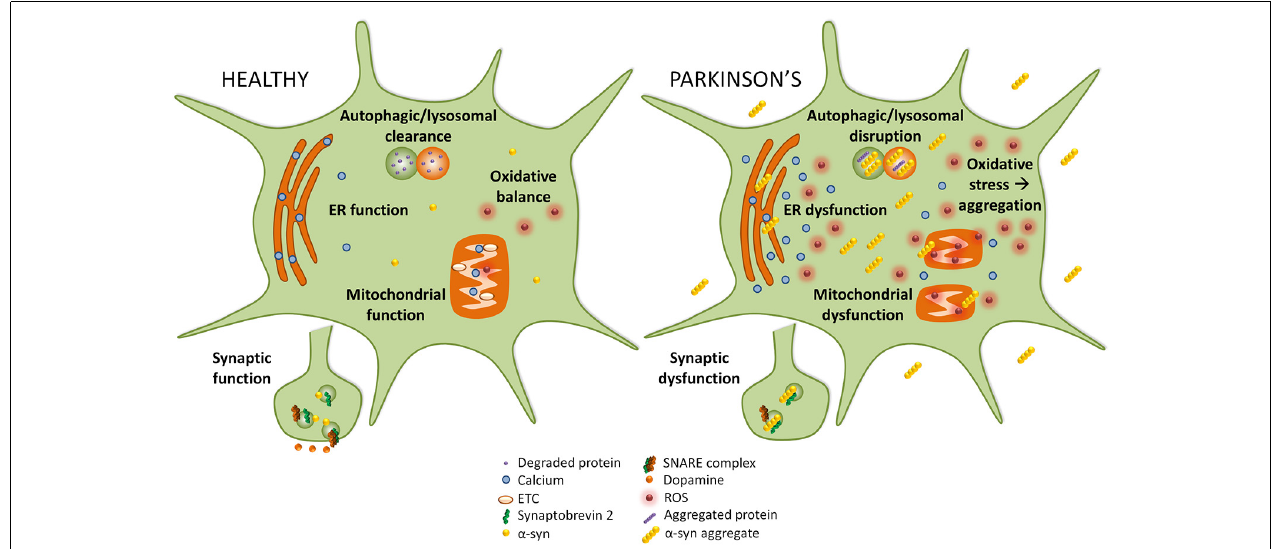
FIGURE 1 | Implicated pathways for α -syn toxicity. To the left, healthy cellular pathways are illustrated, while to the right examples of how these pathways are perturbed in Parkinson’s disease (PD) are shown. Under normal circumstances, autophagic and lysosomal clearance degrades protein and other debris in the cell. In PD these pathways are blocked causing an accumulation of aggregated protein that could itself lead to more aggregation. In healthy cells, endoplasmic reticulum (ER) function is preserved, but in PD ER stress leads to calcium efflux into the cytoplasm. While in healthy cells mitochondrial function and oxidative balance are maintained, in PD the electron transport chain (ETC) and mitochondria function are compromised which causes an increase in reactive oxygen species (ROS) that leads to oxidative stress. Finally, in PD α -syn may interact with synaptobrevin-2, leading to synaptic